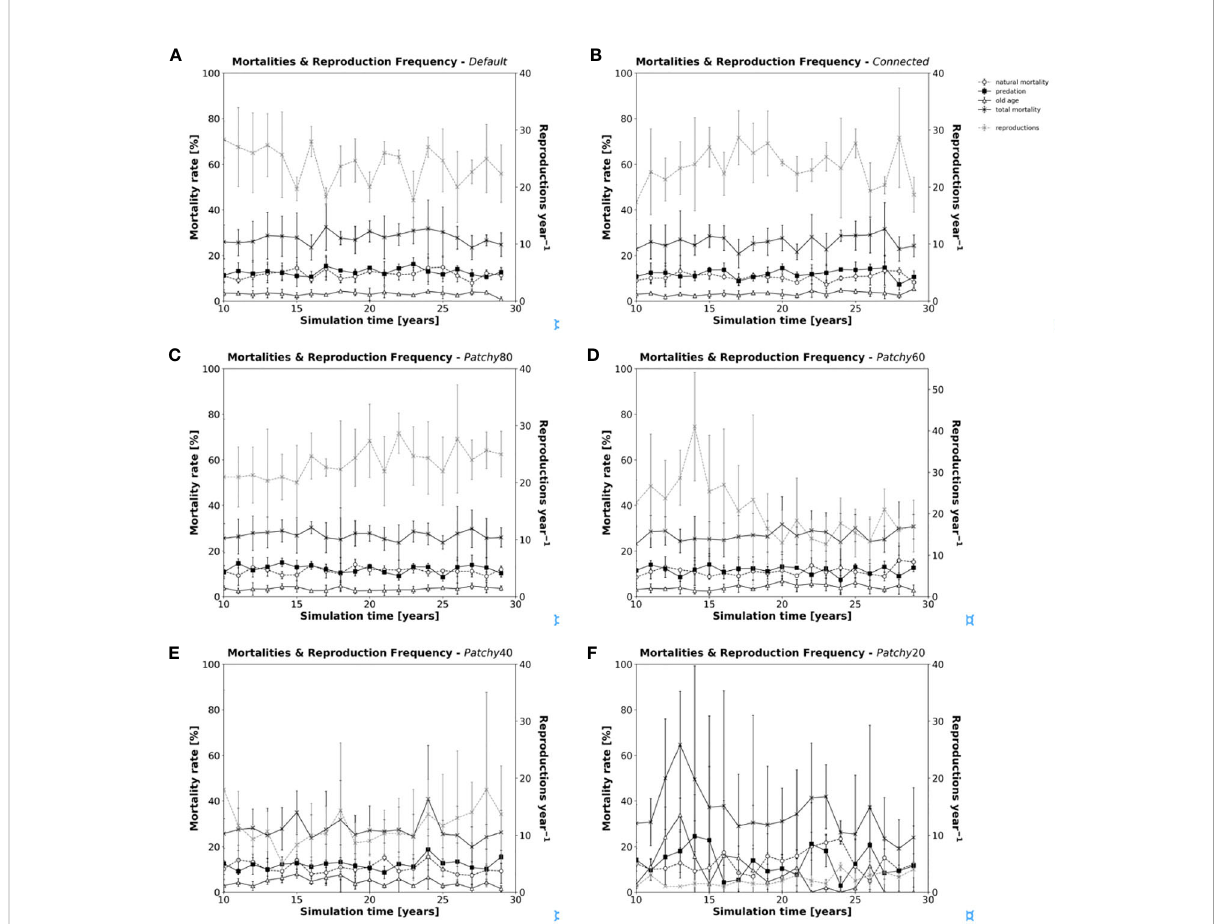
FIGURE 5 Annual mortality rates (in black) and reproduction frequency (grey dashed line) of model fi shes during a simulation under different scenarios: (A) scenario Default , (B) scenario Connected , (C) scenario Patchy_80 , (D) scenario Patchy_60 , (E) scenario Patchy_40 , and (F) scenario Patchy_20 . Values are mean values (± standard deviation (SD)) of replicated simulation